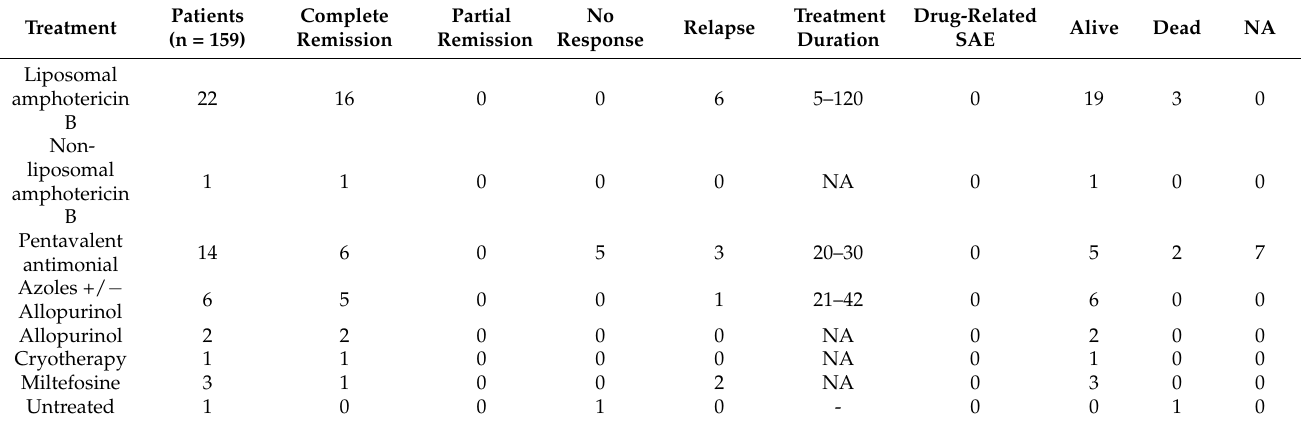
Table 6. Summary of second-line treatment options and treatment-related outcomes of the case reports and case series of Leishmania infection after kidney transplantation (summaries based on individual cases should not be considered as an estimate of the “real